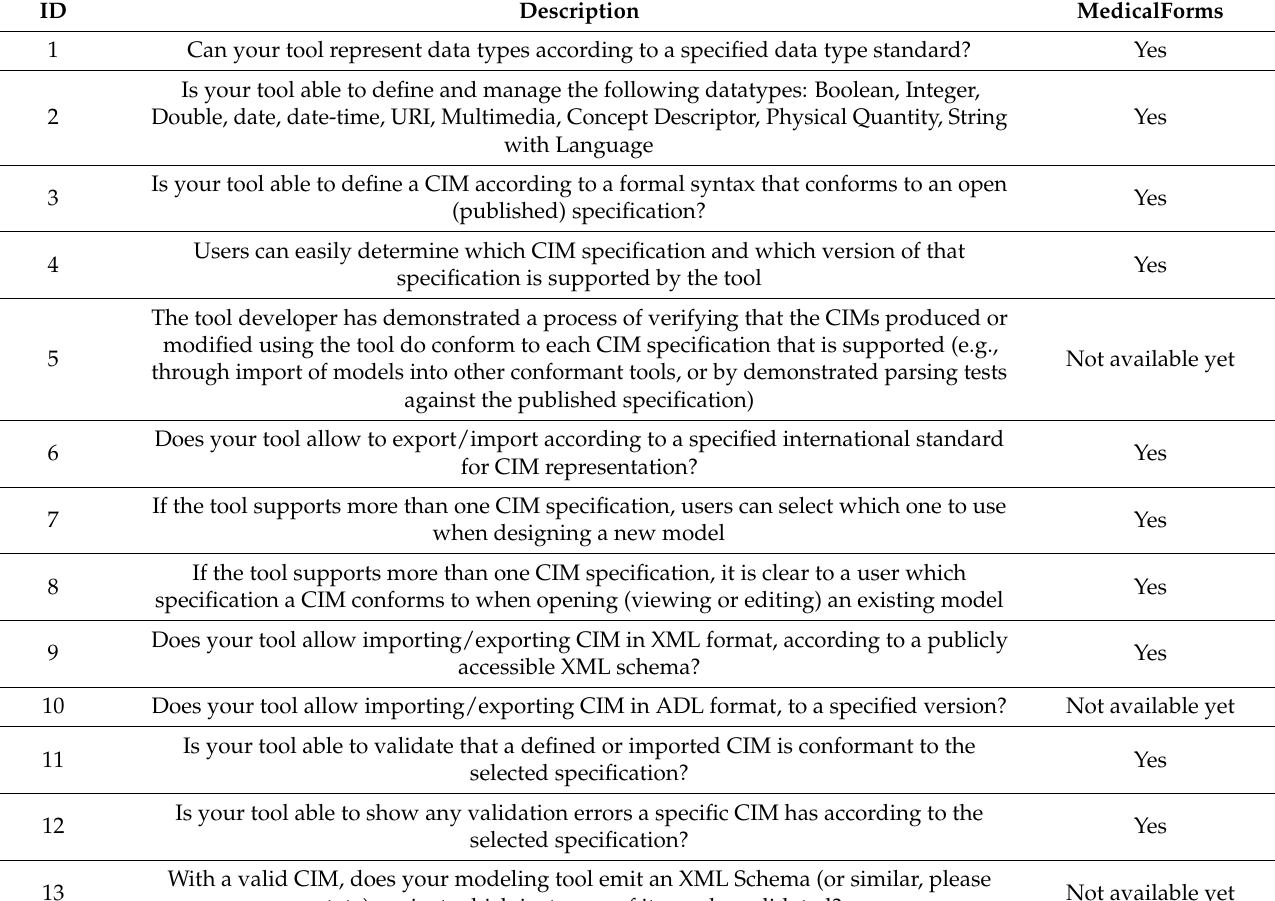
Table A1. Self-evaluation of the tool against the requirements for CIMT. Description